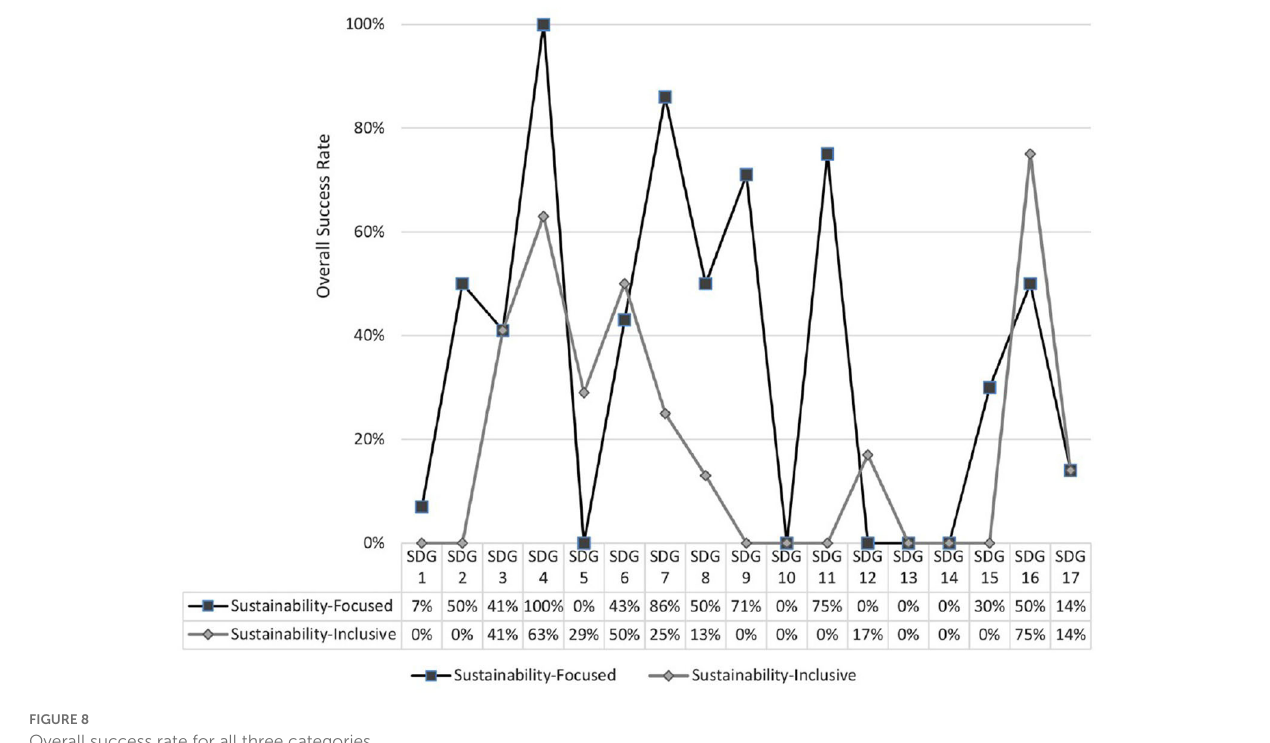
FIGURE8 Overall success rate for all three